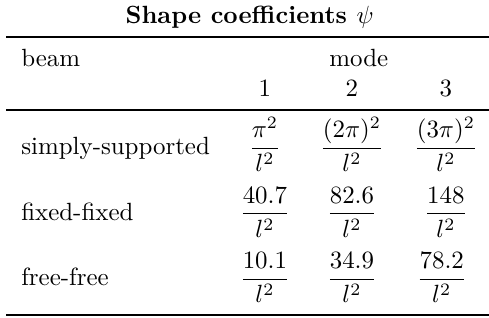
Table 3. Summary of the shape coefficients ψ for three different boundary conditions and the first three mode